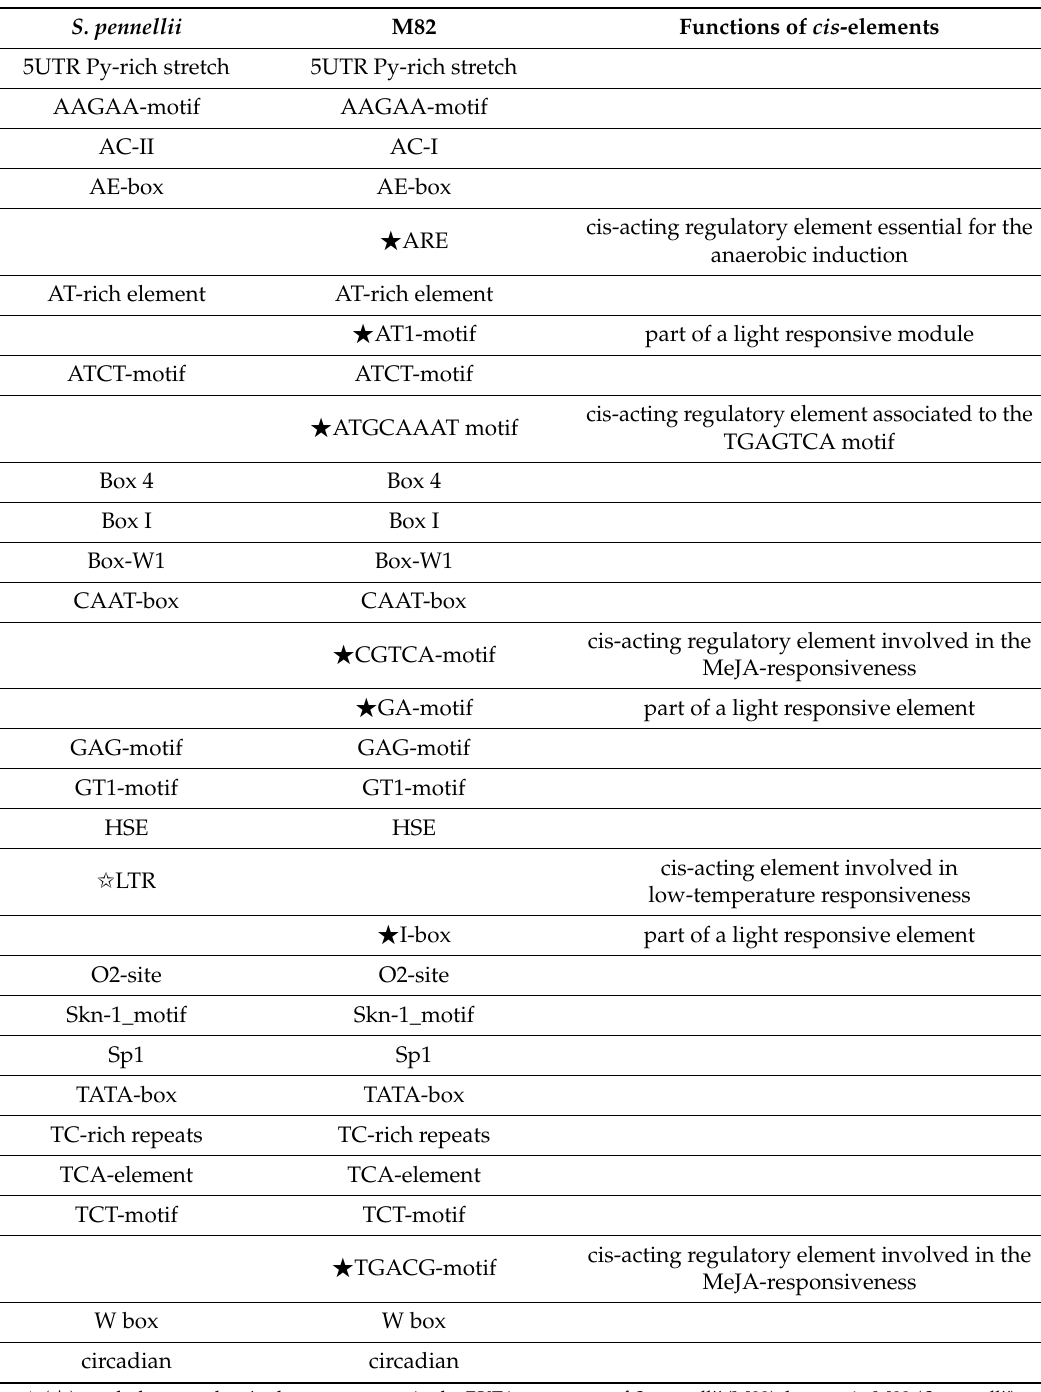
Table 1. The cis -elements identified in the promoters of SlPKE1 (in M82) and SpPKE1 (in S. pennellii ) and the di ff erences of their cis